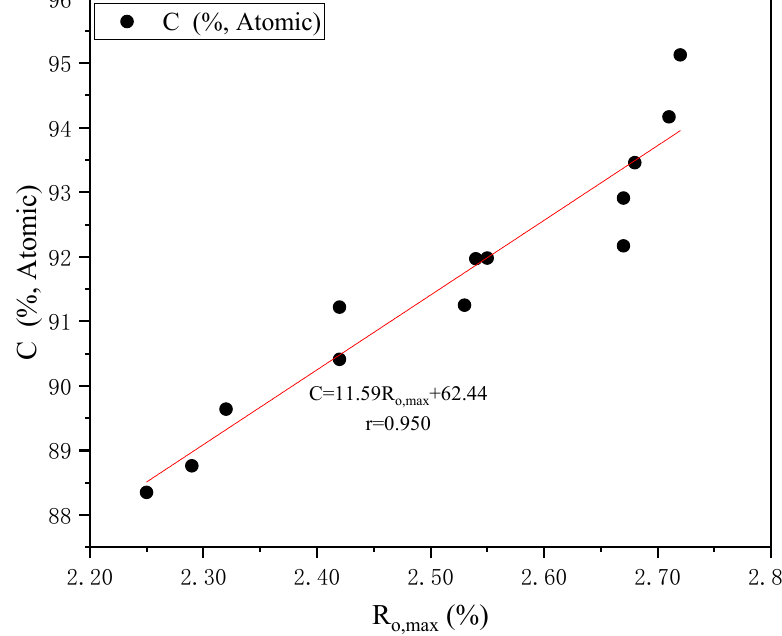
Figure 14. Scatter diagram of carbon content of coal-based graphene.